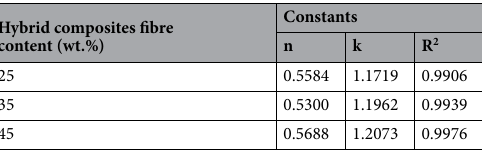
Table 2. The obtained values of constants in water absorption for all hybrid composites.